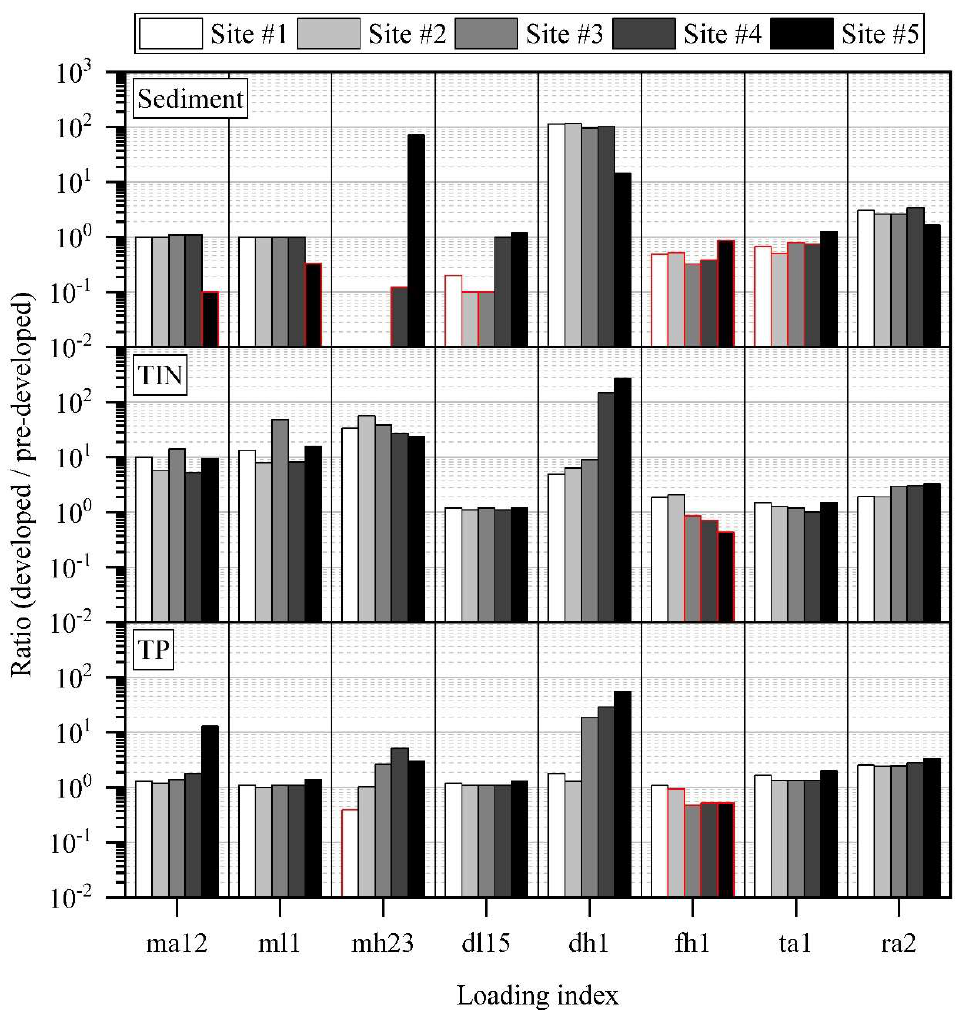
Figure 4. Ratios between observed developed and simulated pre-development loading indices at five gauging sites in Hinkson Creek, Missouri, USA. Ratios less than 1 (i.e., observed < simulated) are outlined in red. Definitions of indices are provided in Table 5. Total inorganic nitrogen is TIN, and total phosphorus is TP.